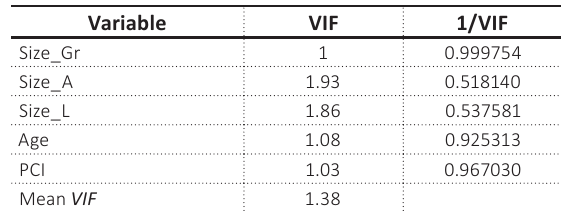
Table 3. Test for multicollinearity for the selected